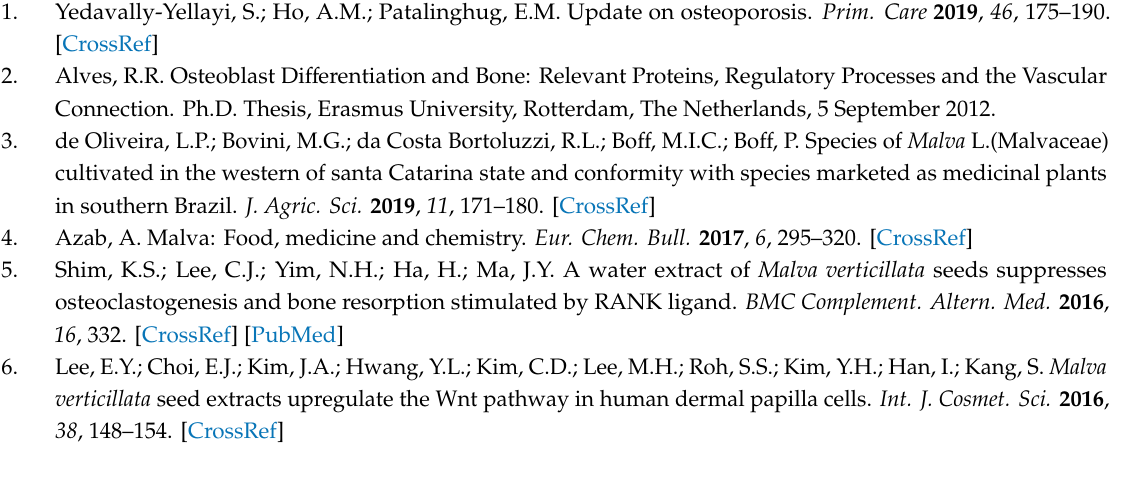
Figure S1: E ff ect of aqueous extract of M. verticillata leaves on osteoclast di ff erentiation. Figure S2: E ff ect of microbial fermentation of M. verticillata leaves on osteoblast di ff erentiation. Figure S3: E ff ect of MVW and MVB on the viability of C3H10T1 / 2 cells. Figure S4: E ff ect of MVW, MVB, and MVWB on the mineralization of C3H10T1 / 2 cells using Alizarin Red S dye. Figure S5: Signaling pathways for osteoblast di ff erentiation. Table S1: Compounds detected by LC-MS analysis of the aqueous extracts of the M. verticillata